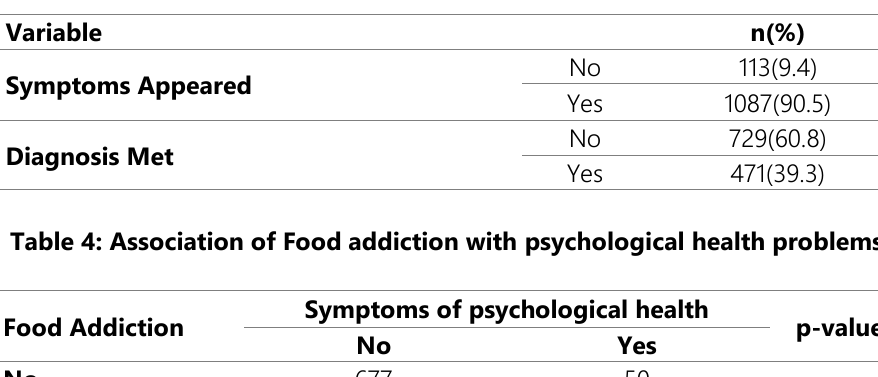
Table 3: Appearance of symptoms and clinical significance of food addiction among the participants.